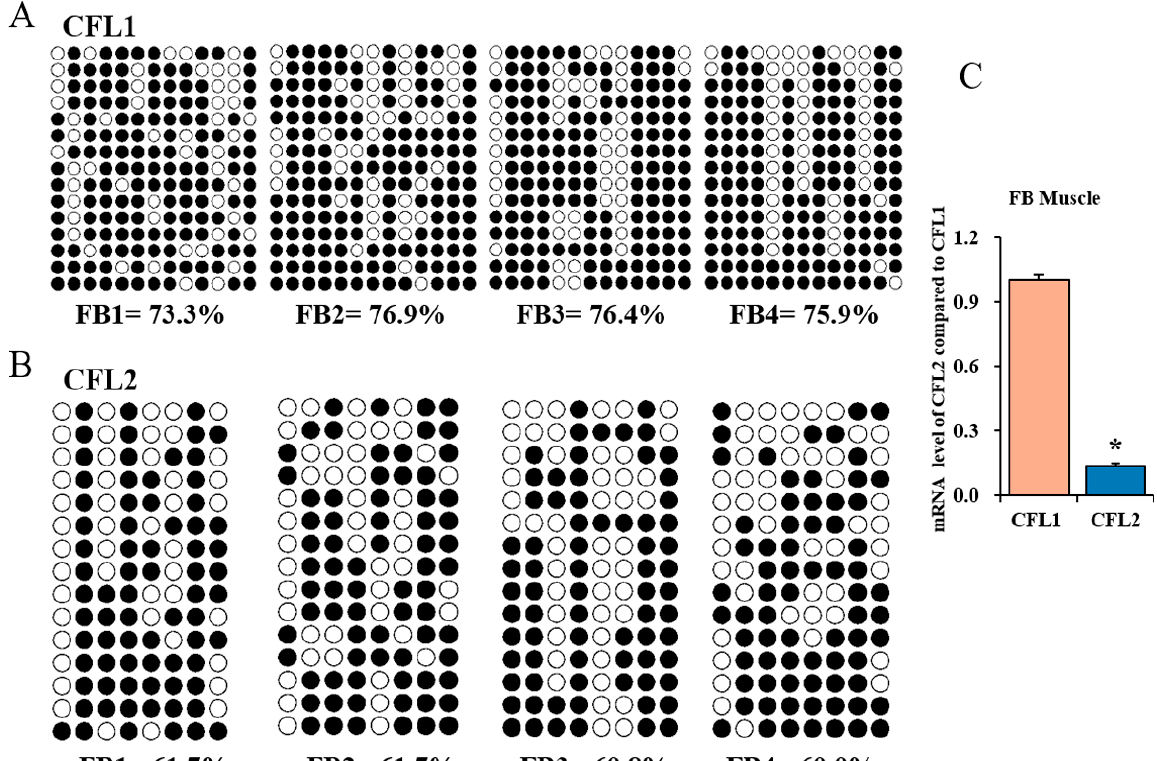
Figure 3. DNA methylation level of CFL1 and CFL2 gene promoters in fetal bovine muscle tissues. DNA methylation patterns of CFL1 ( A ) and CFL2 ( B ) gene promoters in fetal bovine muscle tissues (FB, n = 4) analyzed by BSP. Open circles show unmethylated CpGs and black circles methylated CpGs. mRNA expression level of the CFL2 gene compared to CFL1 was analyzed in muscle tissues ( C ). The mRNA expression level of CFL1 and CFL2 were normalized to GAPDH. The data represent the mean ± SE based on three independent experiments (*, p < 0.05).